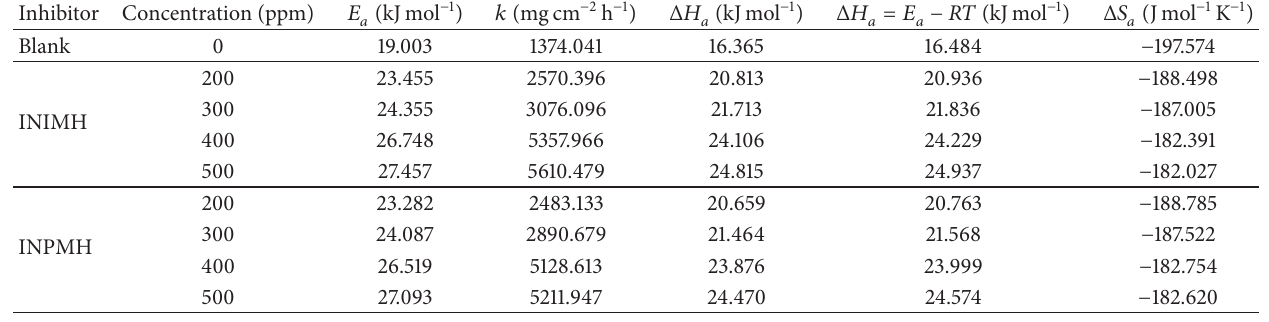
Table 2: Activation parameters for MS in 0.5 M HCl medium in the absence and presence of INIMH and INPMH at 500 ppm. Inhibitor Concentration (ppm)